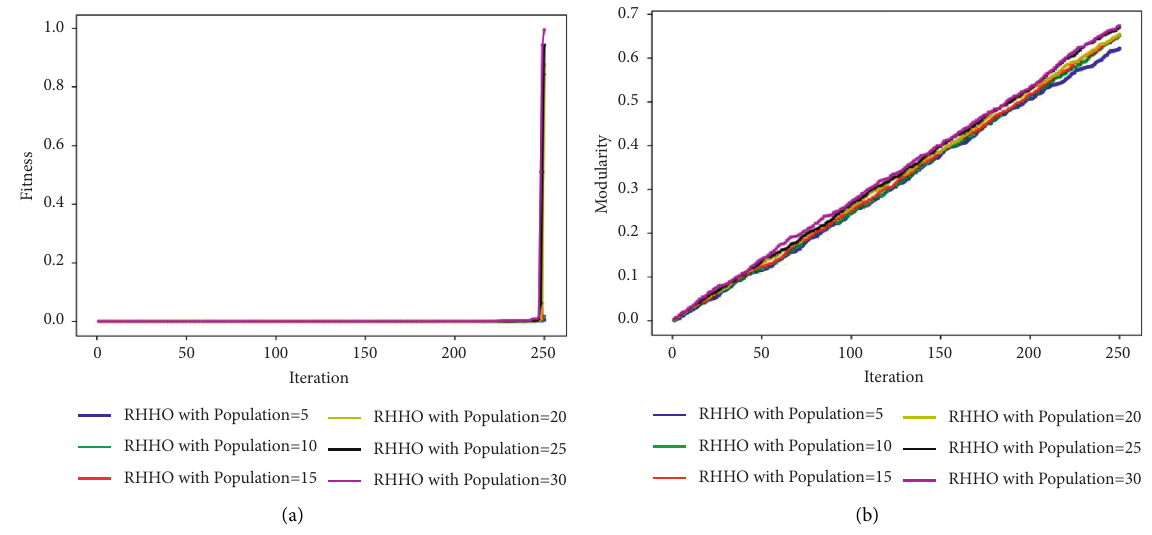
Figure 4: Performance analysis of proposed RHHO method using the cit-HepPh considering (a) fitness and (b) modularity.